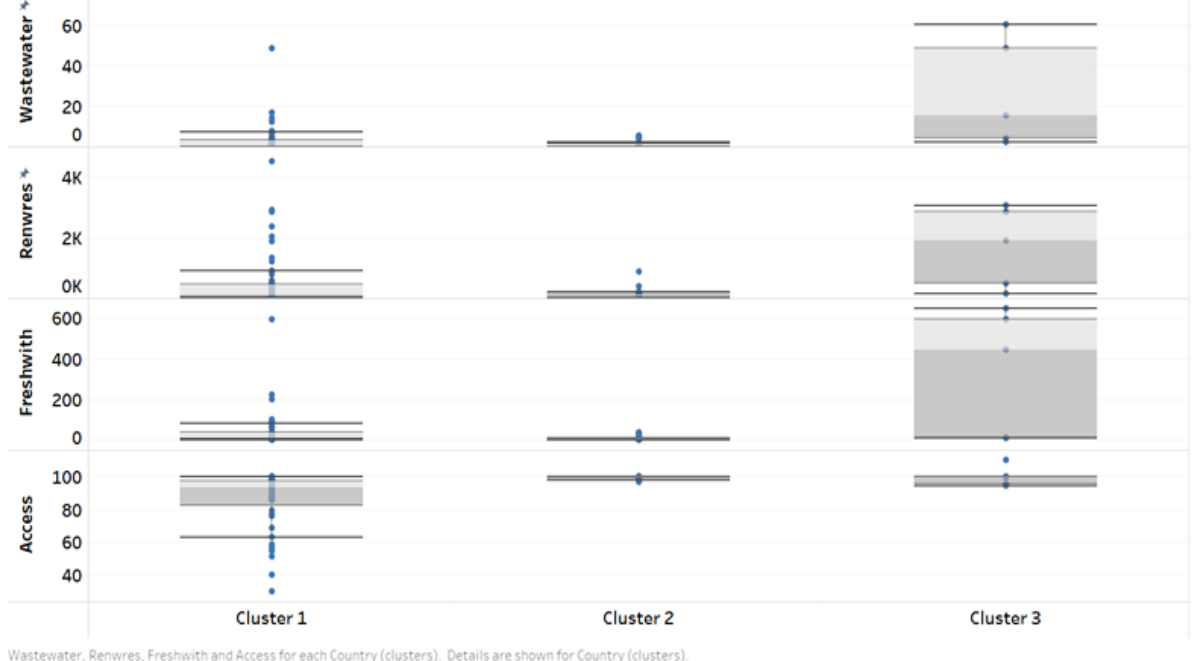
Figure 10. Water variables variation in the clusters based on articles and COVID.